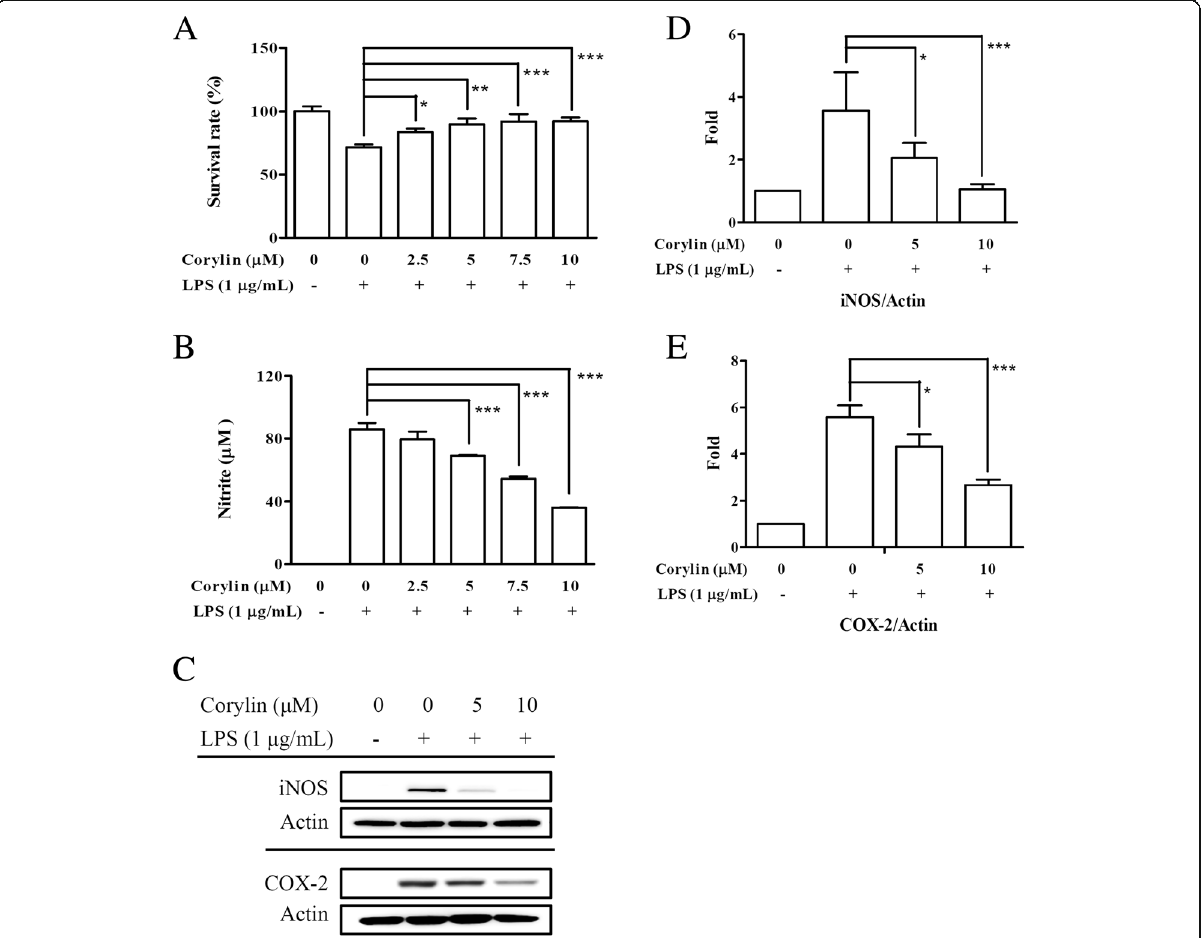
Fig. 1 Effects of corylin on the cell viability and the production of NO by LPS-activated BV2 cells. BV2 cells were pre-treated with various doses of corylin for 1 h, and then treated with LPS (1 μ g/mL) for 24 h. a The survival rate of BV2 cells was measured by MTT assay. b The production of NO in the cell culture supernatant was detected by Griess reaction. c The expression of COX-2 and iNOS was examined by Western blot. Blots are representative blots. The relative ratio of ( d ) iNOS / β -actin and ( e ) COX-2/ β -actin are shown. Data represent mean ± SD of three independent experiments (*: p < 0.05; **: p < 0.01; ***: p < 0.001 vs. LPS